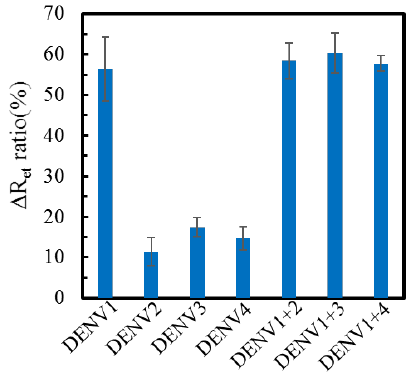
Figure 8. The serotypic selectivity test for the RNA samples extracted from four serotypes of 10 4 PFU / mL DENV ( n = 3).